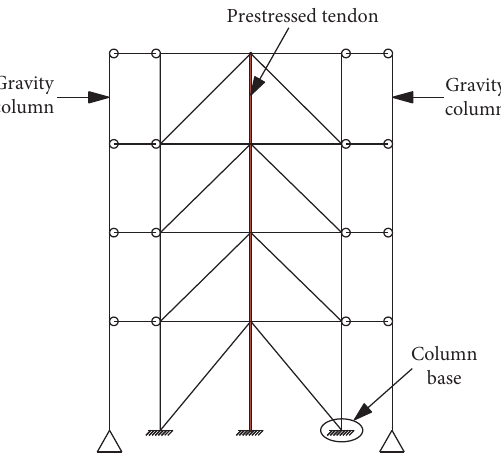
Figure 5: Model of the SC-CBF